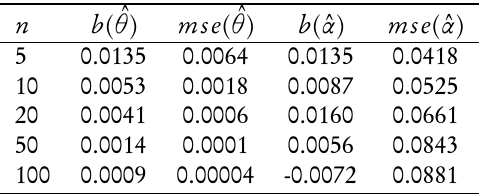
Bias and mean square error of the m.l.e.’s ( ˆ θ , ˆ α ) , for the power hypergeometric distribution {